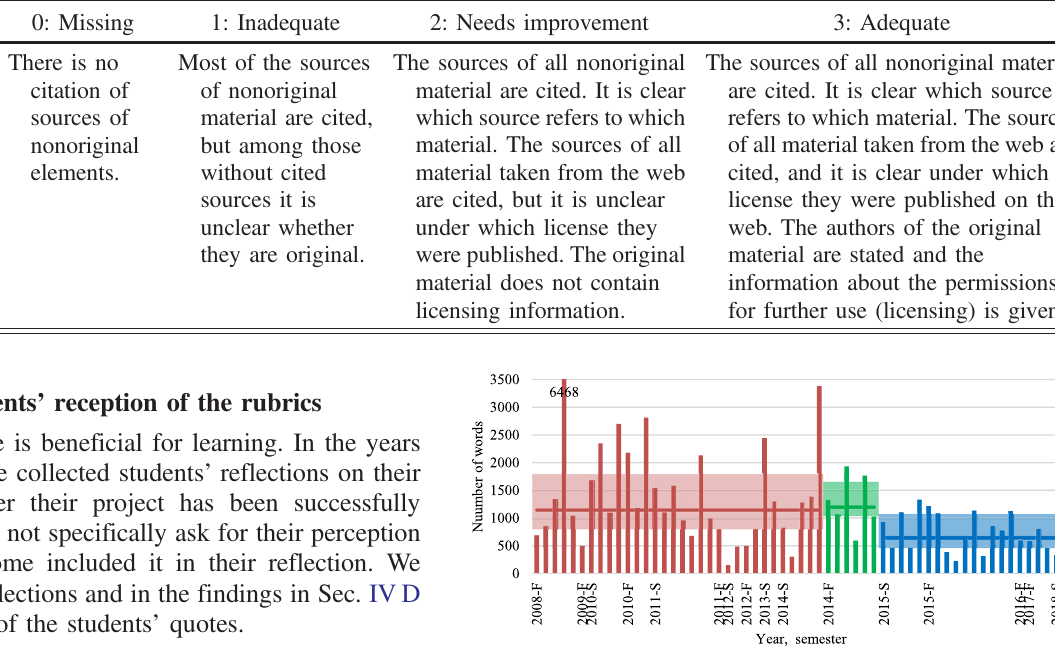
TABLE VIII. The sixth and last line of the new rubric for the ability of writing a report in the form of a web page. Subability